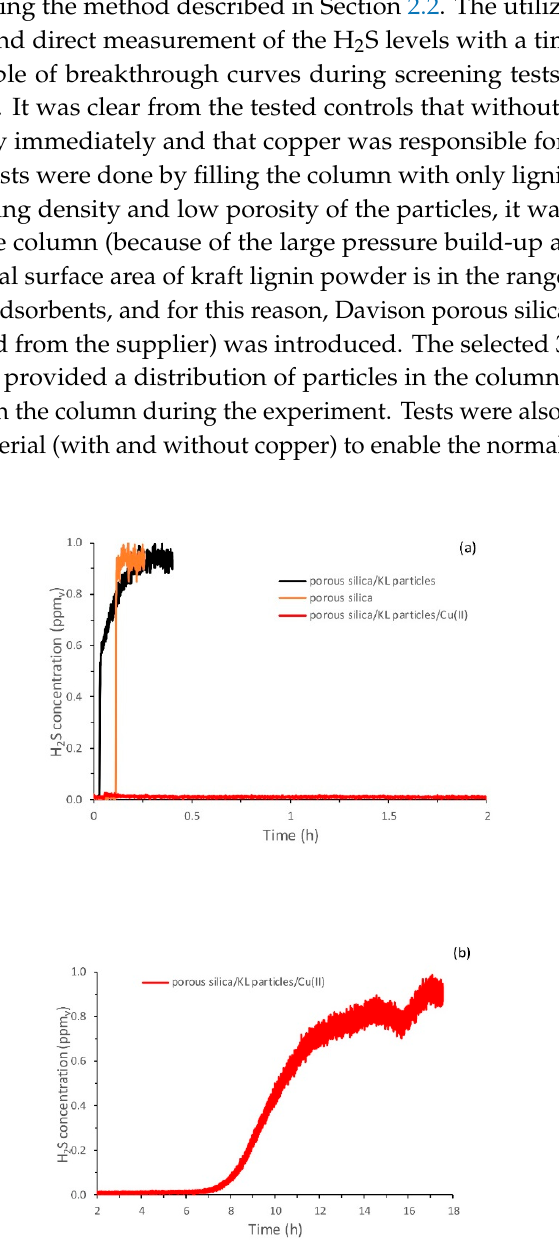
Figure 2. ( a ) Adsorption curves of H 2 S for the silica particles (orange line) and a blend of silica and kraft lignin particles with (red line) and without (black line) adsorbed copper. ( b ) Continuation of the experiment for the blend of particles with adsorbed copper (red line).